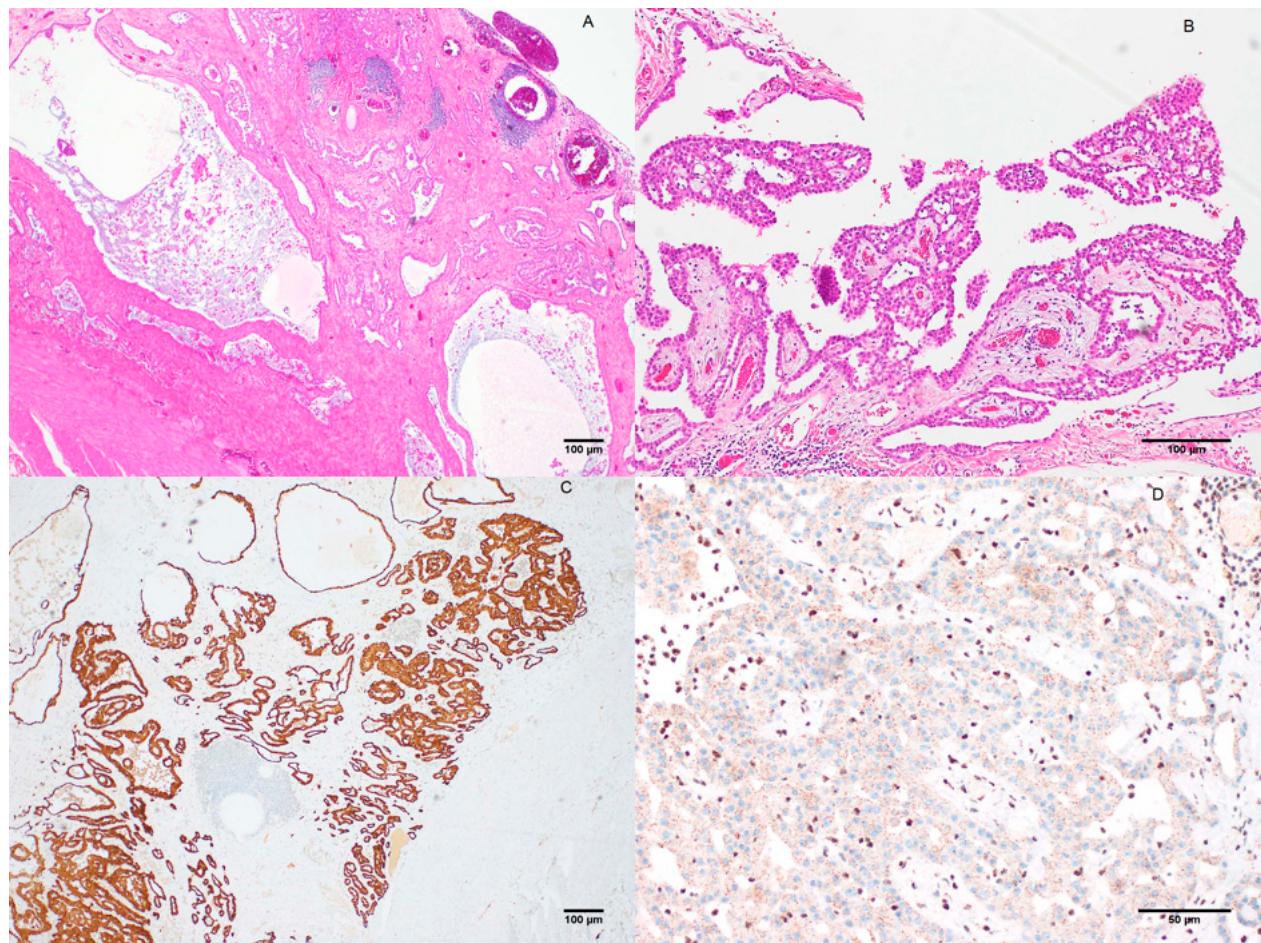
Figure 2. Invasive mesothelioma of epithelioid type forming gland-like structures. ( A ) H&E (Hematoxylin-Eosin stain) 4× magnification. ( B ) Atypical mesothelial surface proliferation in close vicinity to invasive tumour 10× magnification. ( C ) Positive labelling for calretinin in invasive mesothelioma 4× magnification. ( D ) Loss of nuclear labelling for BAP1 in invasive mesothelioma, with retained nuclear labelling of inflammatory cells (internal control) 20× magnification.